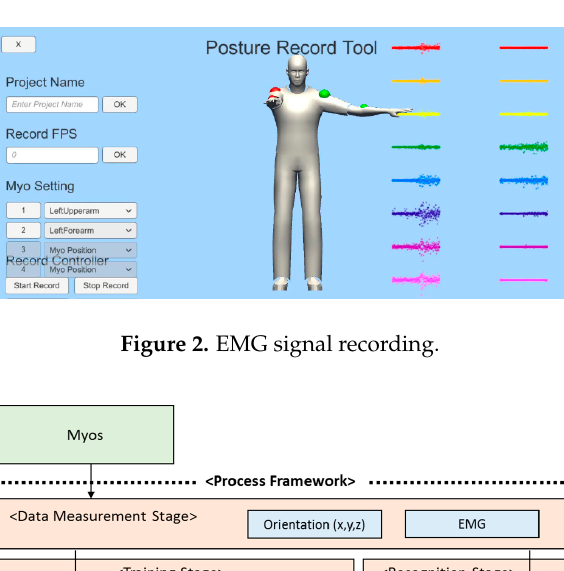
Figure 2. EMG signal recording.